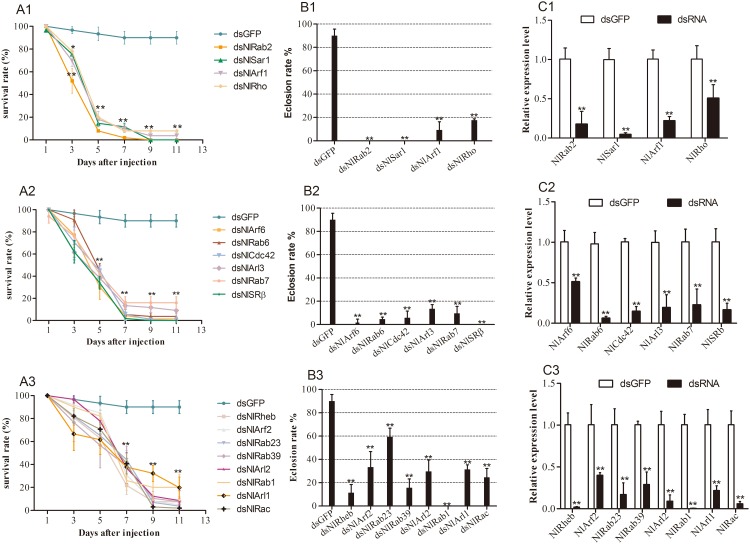
Injection of dsRNA on survival (A1-A3), eclosion (B1-B3) of N. lugens and mRNA level of target gene (C1-C3).The third instar nymphs were injected with specific dsRNA and were observed for phenotypic variations at 48h intervals. Individuals treated with dsGFP were used as a control. The survival and eclosion rate were calculated from three biological replicates (mean ± SD). For each treatment, n = 30 nymphs. mRNA level of target gene at 4d after injection in N.lugens were analyzed by qRT-PCR with 2-ΔΔCt method from three biological replicates (n = 5, mean ± SD). **P < 0.01, * P < 0.05.